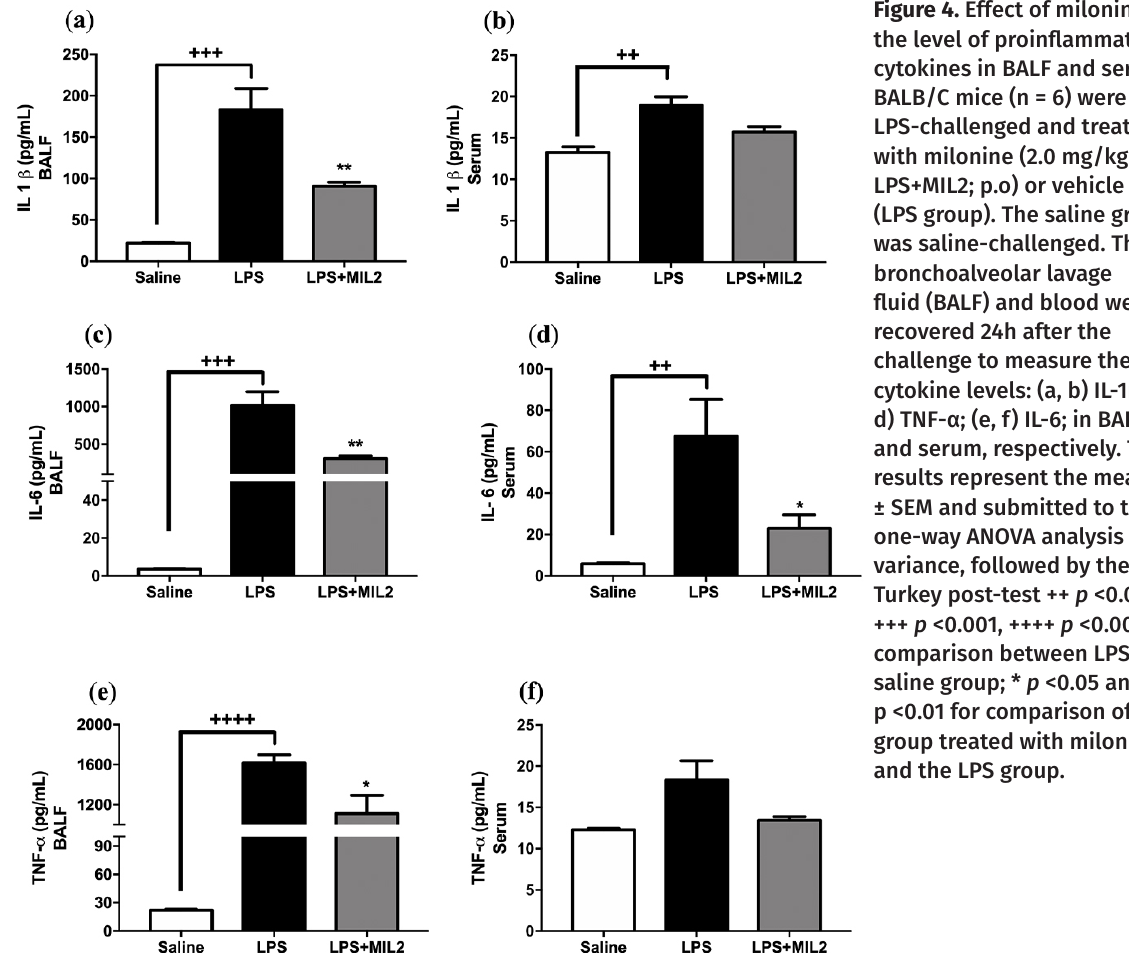
Figure 4. Effect of milonine on the level of proinflammatory cytokines in BALF and serum. BALB/C mice (n = 6) were LPS-challenged and treated with milonine (2.0 mg/kg; LPS+MIL2; p.o) or vehicle (LPS group). The saline group was saline-challenged. The bronchoalveolar lavage fluid (BALF) and blood were recovered 24h after the challenge to measure the cytokine levels: (a, b) IL-1ß; (c, d) TNF-α; (e, f) IL-6; in BALF and serum, respectively. The results represent the mean ± SEM and submitted to the one-way ANOVA analysis of variance, followed by the Turkey post-test ++ p <0.01, comparison between LPS and saline group; * p <0.05 and ** p <0.01 for comparison of the group treated with milonine and the LPS